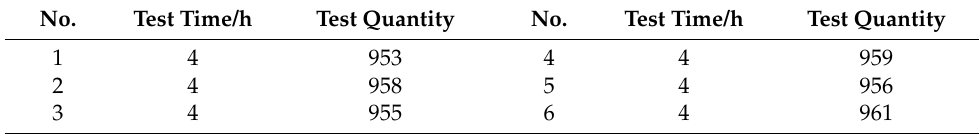
Table 6. Record of test